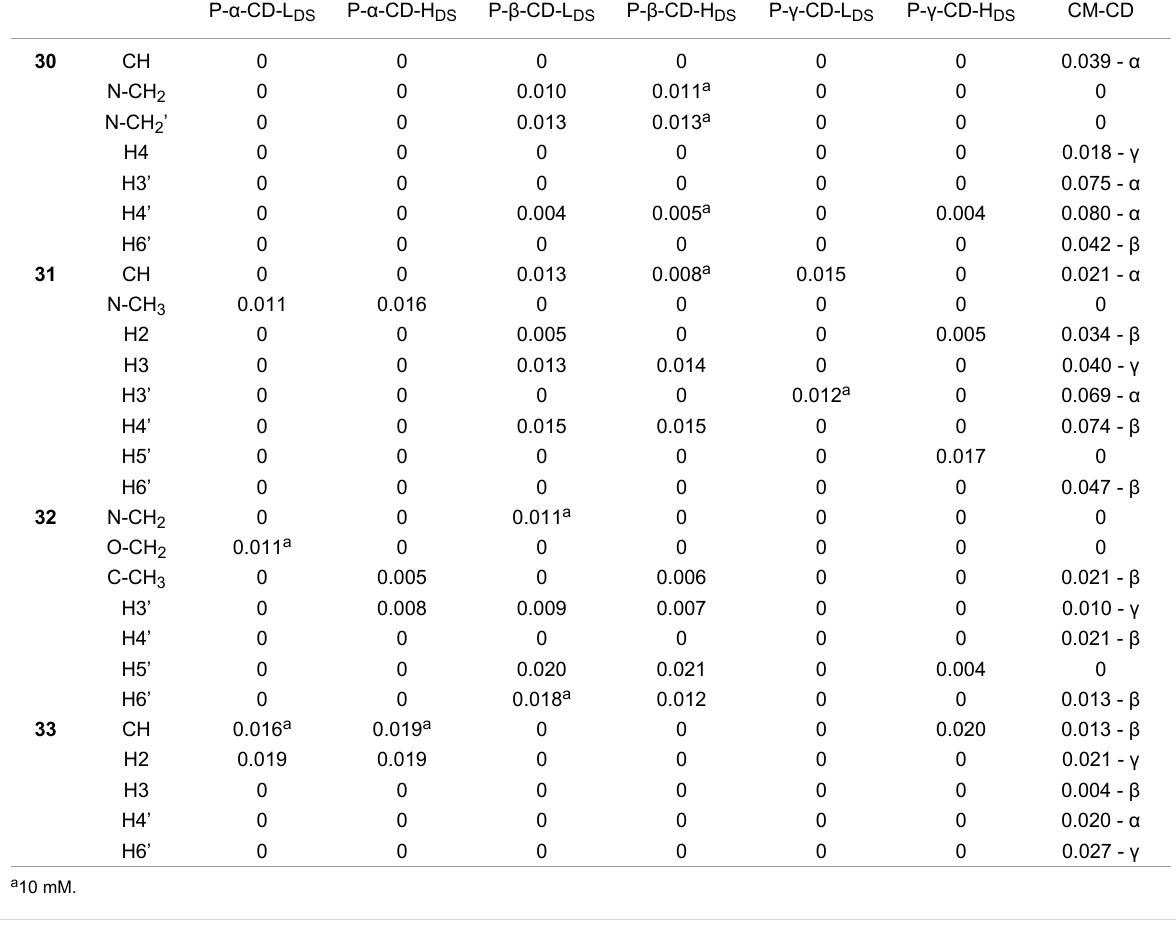
Table 6: Enantiomeric differentiation in ppm in the 1 H NMR spectra (400 MHz) of 30 – 33 (10 mM) with P-CDs and CM-CD [21,31] in D 2 O. The con- centration of the cyclodextrin is 20 mM unless otherwise indicated.